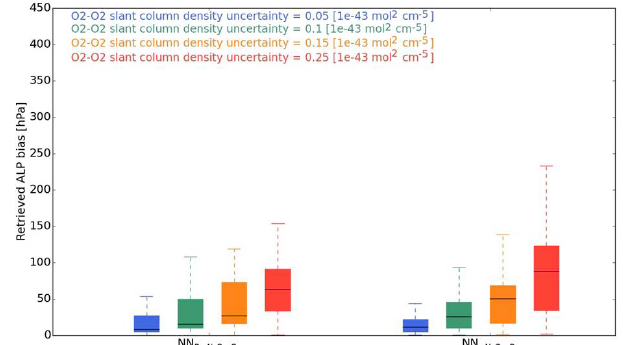
Figure 9. Box–whisker plots of ALP retrieval biases induced by O 2 − O 2 SCD N s uncertainties. The assumed conditions are O 2 − O 2 fine scattering aerosols ( α = 1.5, ω 0 = 0.95, g = 0.7), climatology mid-latitude summer temperature, NO 2 , O 3 and H 2 O profiles, sur- face pressure of 1010hPa, surface albedo of [0.03–0.05–0.07] and combination of θ 0 − θ of [25–25, 50–25, 25–45 ◦